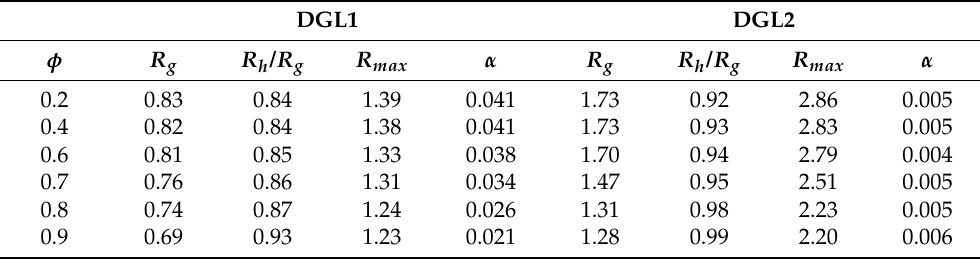
Figure 2. The snapshots of DGL2 at different methanol fractions φ . Upper pictures from left to right: 0.2, 0.4 and 0.6; bottom pictures from left to right: φ = 0.7, 0.8, 0.9. Table 1. The global characteristics of the DGL1 and DGL2 dendrigrafts averaged through the whole trajectory time: the radius of gyration R g (nm), the ratio R h / R g , the effective radius R max (nm) (see Section 2.2), and asphericity parameter α at different methanol fractions φ